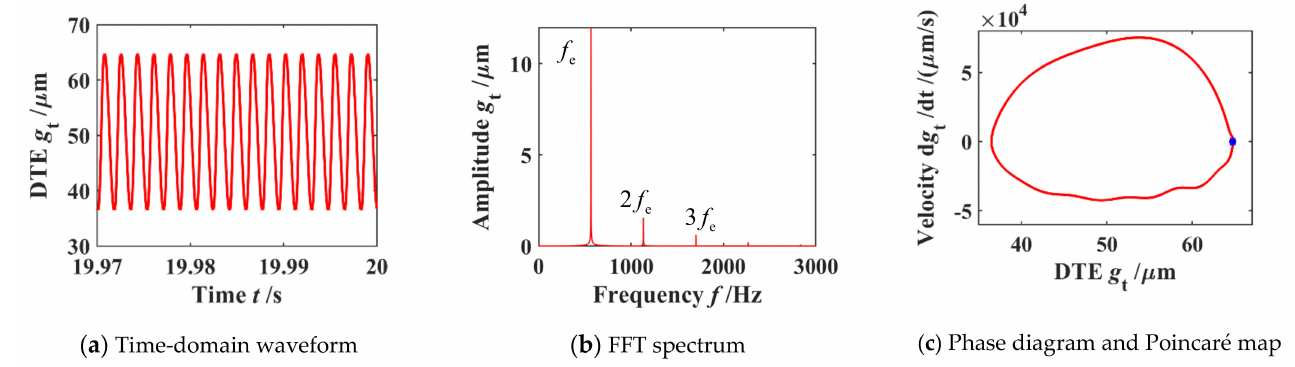
Figure 17. Dynamic responses at n 1 = 1700 rpm.